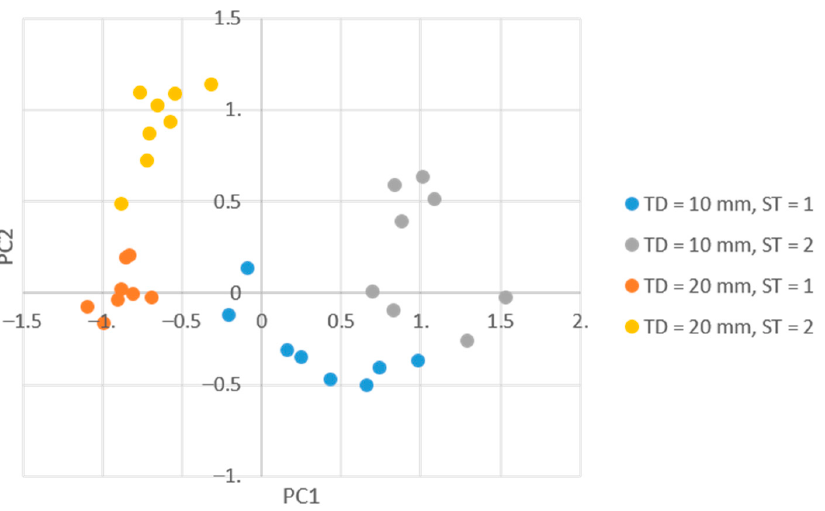
Figure 8. Score plot of the first two components colored by tool diameter and sheet